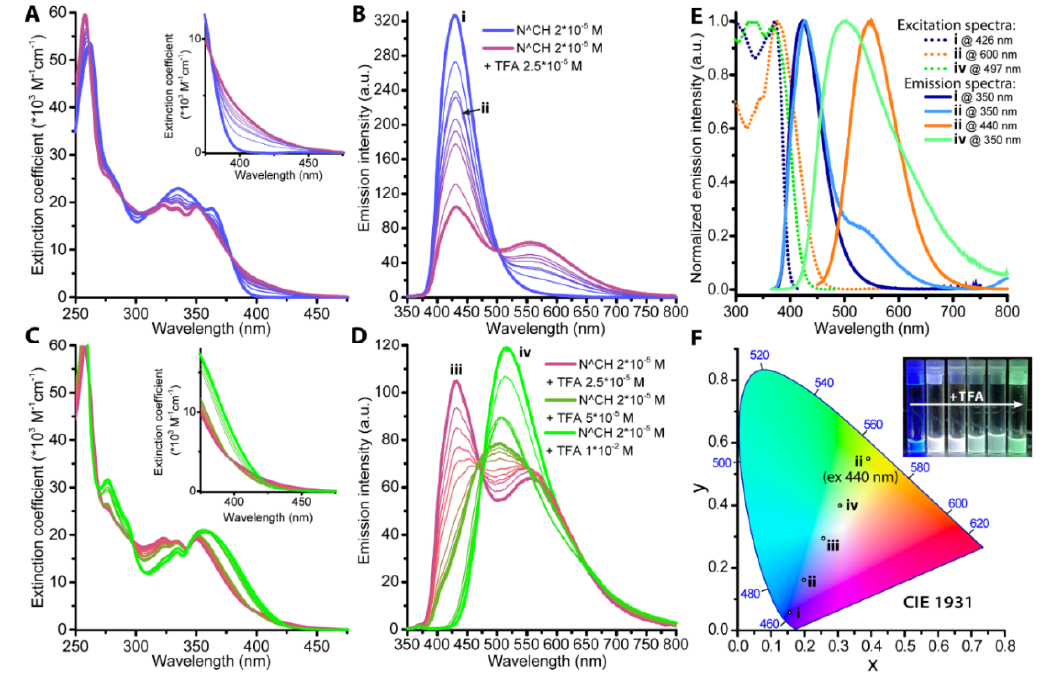
Figure 2. Spectral changes of N^CH in CH 2 Cl 2 upon titration with TFA: ( A , C ) absorption spectra, ( B , D ) emission spectra λ ex = 365 nm; ( E ) excitation and emission spectra of the representative solutions at different stages of the N^CH protonation chosen from the panels B and D (i— N^CH , ii— N^CH + TFA 10:1, iii— N^CH + TFA 1:1, iv— N^CH + TFA excess); and ( F ) CIE 1931 chromaticity diagram with an embedded photograph of the N^CH solution in CH 2 Cl 2 at various TFA concentra- tions, λ ex = 365 nm.